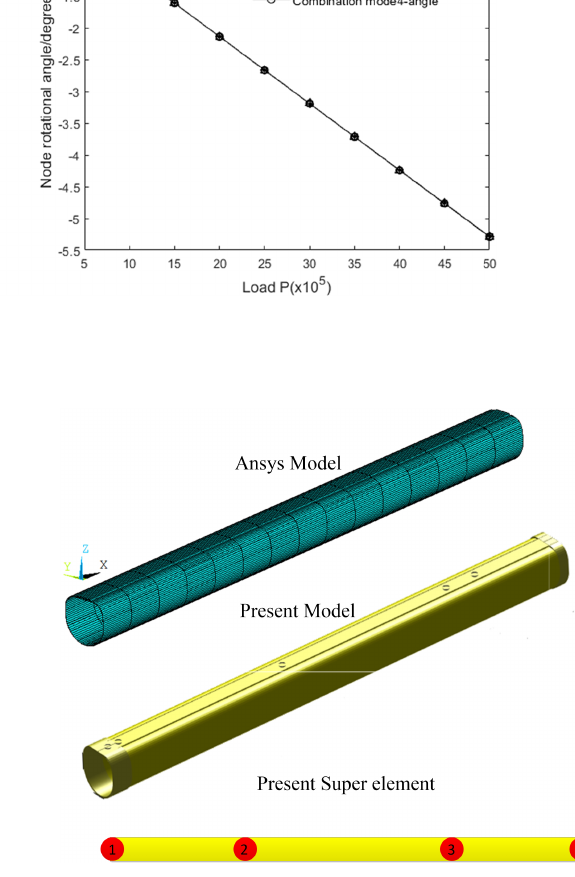
Figure 13. Ansys and present finite element model of boom section 7.